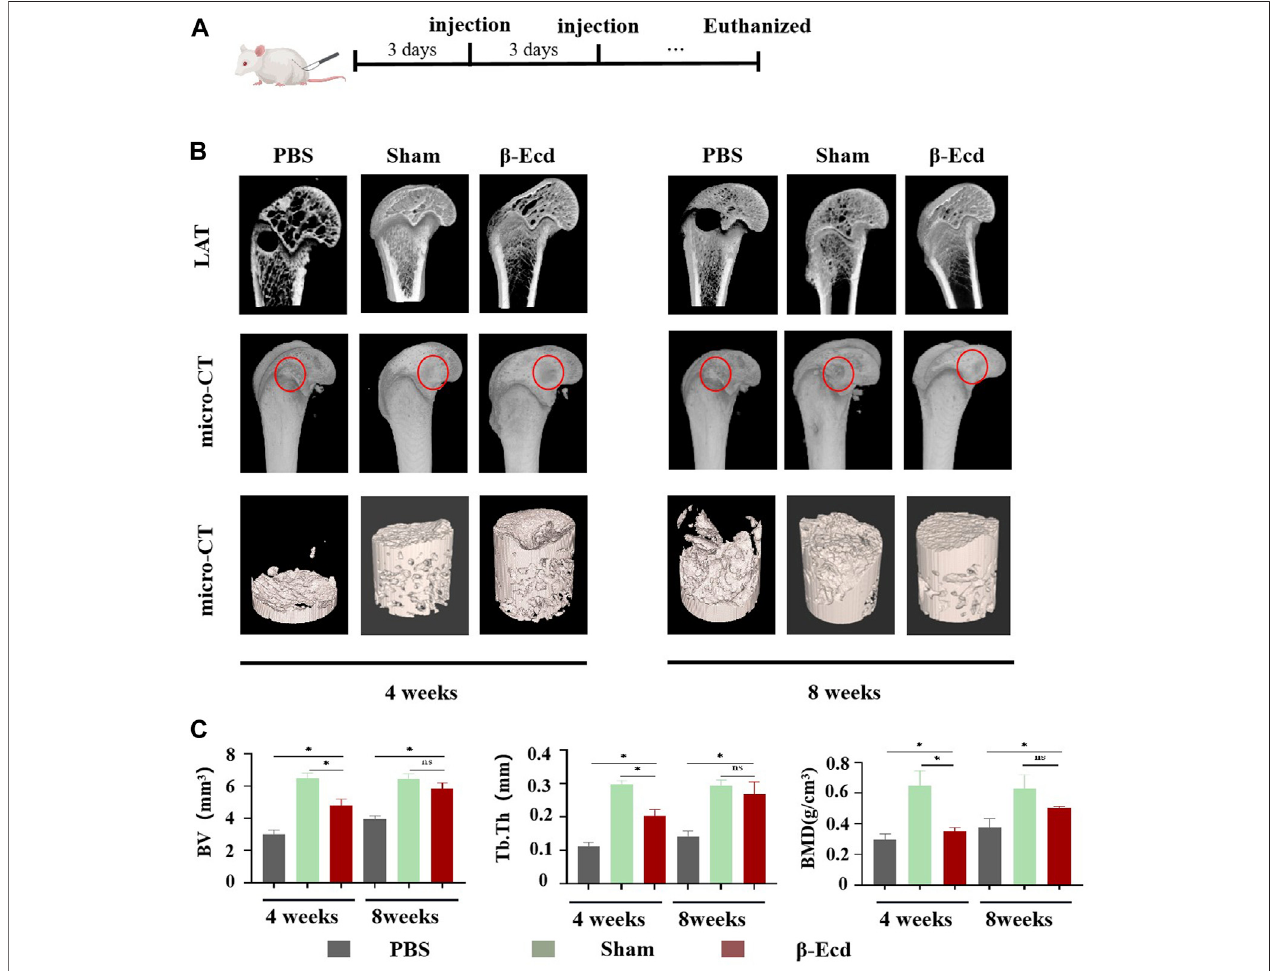
FIGURE 6 | The results of the Micro-CT test show that β -Ecd accelerates bone healing in rats. (A) Critical size bone defect model of the distal femur and β -Ecd injection; (B) Micro-CTanalysisofnewboneformation,CT-voxsoftwaretoidentifynewboneandanalyzethedistributionofnewboneat8 weeks.Itcanbeseenthatthe new bone formation in the sham operation group and the β -Ecd group was signi fi cantly increased compared to the PBS group at 4 and 8 weeks, but there were no signi fi cant differences between the sham operation group and the β -Ecd group; (C) Statistics of new bone microstructural parameters in the 4 week and eighth week, including bone mineral density (BMD), bone tissue volume (BV), trabecular bone thickness (Tb.Th). Each group contained three replicates, and the data were analyzed by one-way ANOVA for multiple comparisons. *p < 0.05, ns, nosigni fi cant.